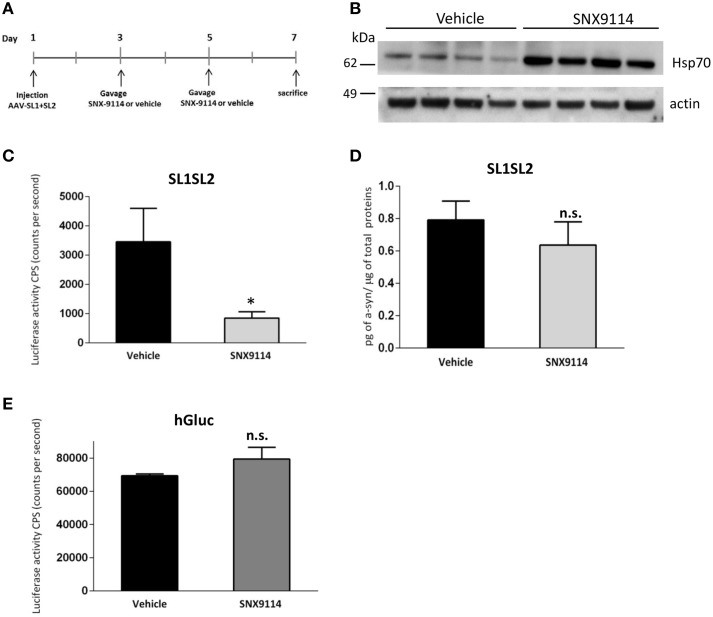
Effect of SNX-9114 in SL1SL2 rat substantia nigra. (A) Illustration of the timeline experiment of SNX-9114 treatment in vivo. (B) Hsp70 induction in the SN was evaluated by western blotting and actin was used as a loading control. Western blot shows four representative animals for each group. (C) Level of oligomers in the SN of the vehicle group (n = 6) and the treated group (n = 6) was assessed by luciferase activity 1 week after viral vector delivery. A significant decrease of αsyn oligomerization was observed after 2 mg/kg SNX-9114 treatment [Student's T-test, T(9) = 2.46; *p < 0.05]. (D) Expression of hαsyn in injected SN homogenate was analyzed by ELISA and is expressed as amount of hαsyn normalized to the total amount of protein in the homogenates. (E) Control rats injected with hGluc and treated either with vehicle (n = 2) or SNX-9114 (n = 2). The luciferase activity was not affected by the drug treatment as p > 0.05. n.s, not significant.